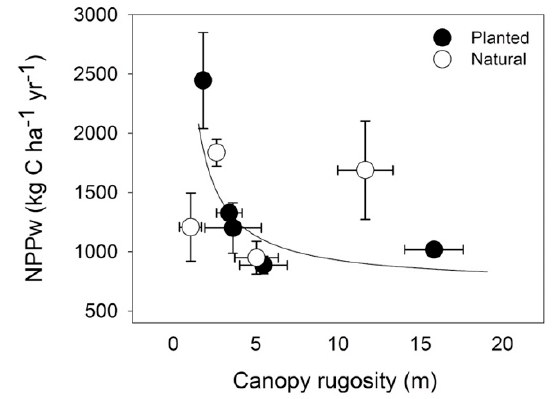
Figure 4. Stand mean annual wood net primary production (NPP w , ± SE, n = 3) in relation to mean canopy rugosity (± SE, n = 3) in planted and natural pine stands. The solid line denotes a significant ( P < 0.05) relationship in planted pine ( r 2 = 0.43).